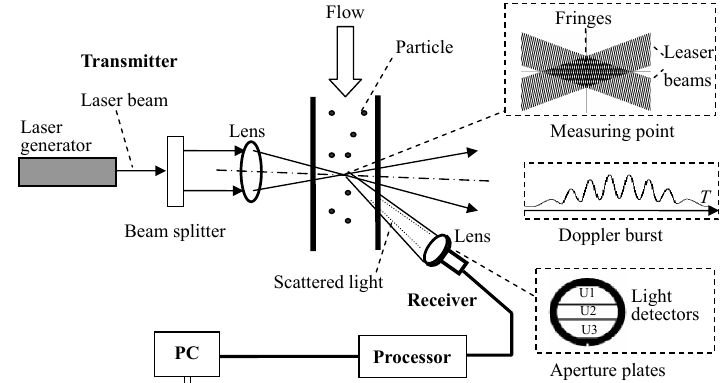
Figure 2. Basic structure of PDA. The velocities and sizes of particles passing through the measuring point are obtained by analyzing the light scattered by the